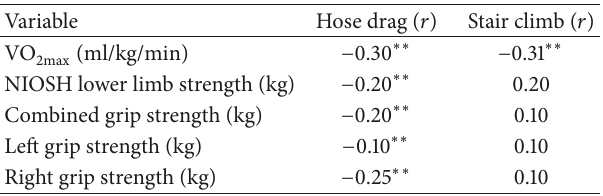
Table 3: Intercorrelationsamong firefighters’ fitnessparametersand individual task completion